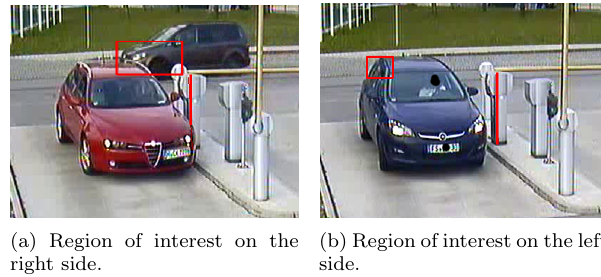
Figure 4: The measurement process is disturbed by a car standing in the background. A new position for the region of interest fixes the